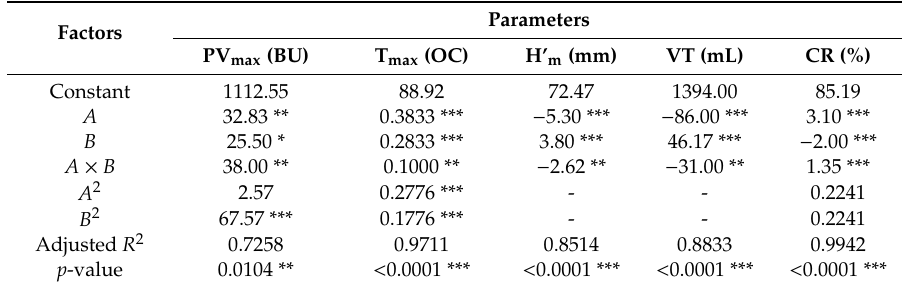
Figure 2. The graphical representations of the Falling Number and Amylograph parameters: ( 2a ) falling number value (FN); ( 2b ) peak viscosity (PV max ); ( 2c ) temperature at peak viscosity (T max ); and ( 2d ) gelatinization temperature (T g ). Table 3. E ff ects of formulation factors expressed as their corresponding coe ffi cients on the predictive models for dough rheological properties during fermentation, gelatinization properties, and α -amylase activity of sea salt–dry sourdough